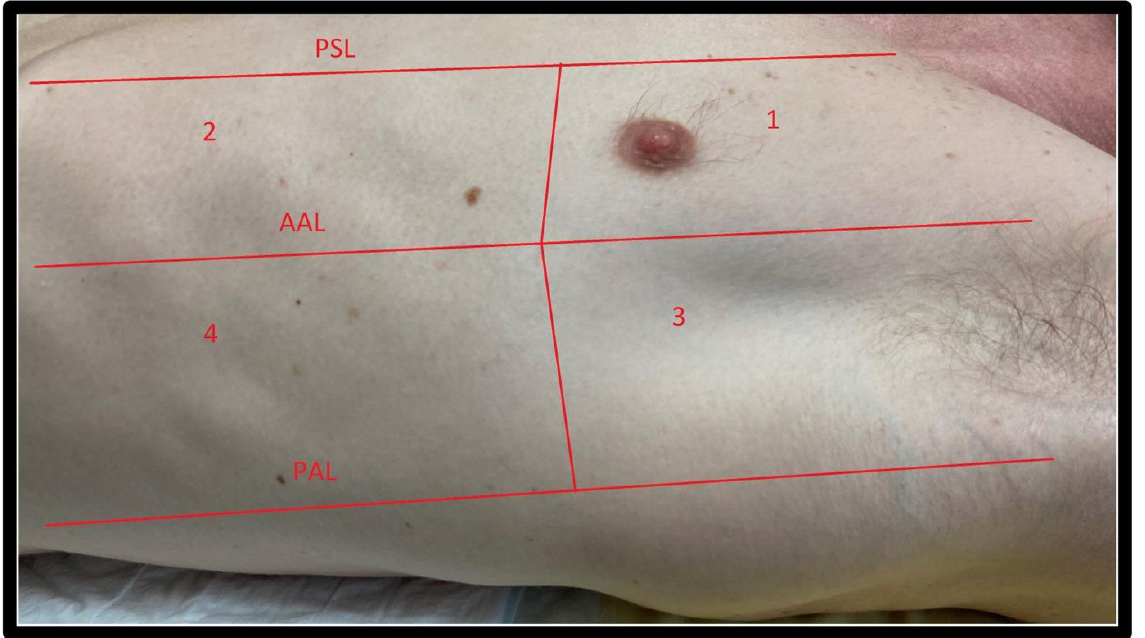
Figure 4. International Consensus Conference for point-of-care lung ultrasound areas. Four chest areas per side considered for complete eight-zone lung ultrasound examination (modified from Volpicelli et al. [5]). AAL: Anterior Axillary Line; PAL: Posterior Axillary Line; PSL: Parasternal line.